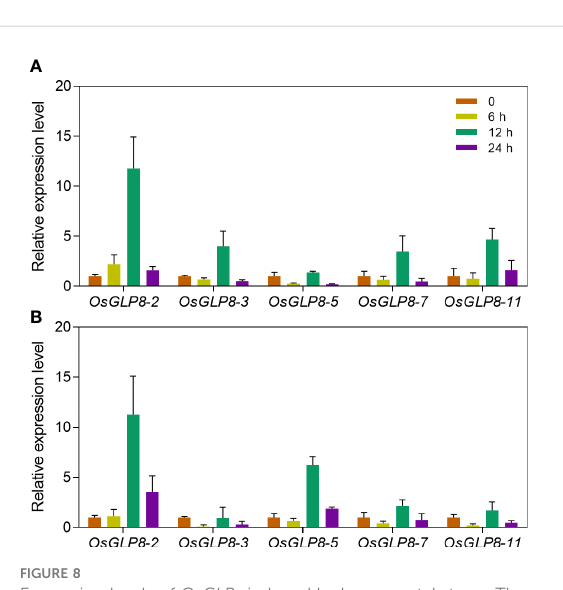
FIGURE 8 Expression levels of OsGLPs induced by heavy metal stress. The expression of OsGLP8 - 2 , OsGLP8 - 3 , OsGLP8 - 5 , OsGLP8 - 7 , and OsGLP8 - 11 in two-week-old wild-type seedlings treated with 10 m mol L − 1 CdCl m mol L − 1 CuSO 4 (A) or 25 2 (B) for 0, 6, 12, and 24 hours. Values are the mean ± SD; n = 3. Different letters indicate a difference of p ≤ 0.05 by the LSD